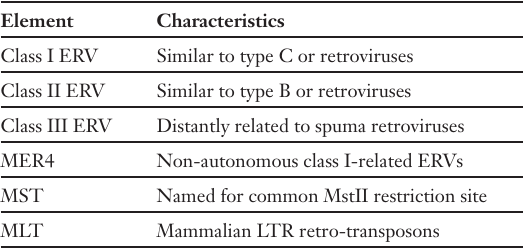
Superfamilies of LTR-containing retroelements. The LTR-retrotransposons are classed in six major superfami- lies and based on sequence analysis are related to the retro- viral subfamilies, suggesting different infectious events. Reproduced from Bannert et al.